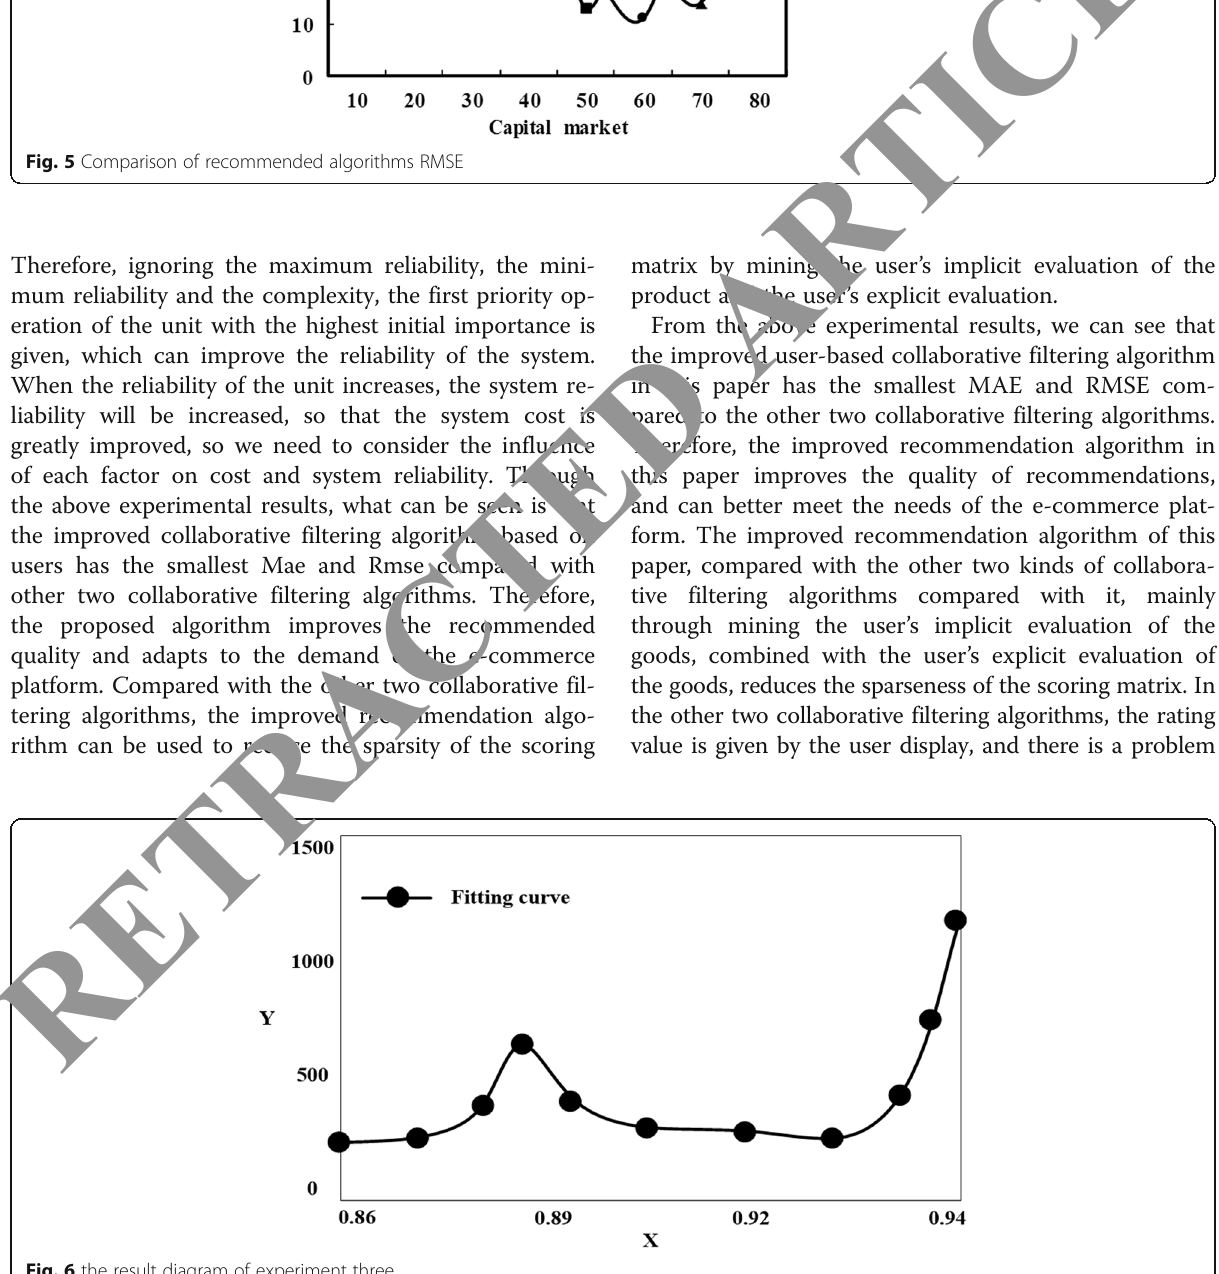
Fig. 6 the result diagram of experiment